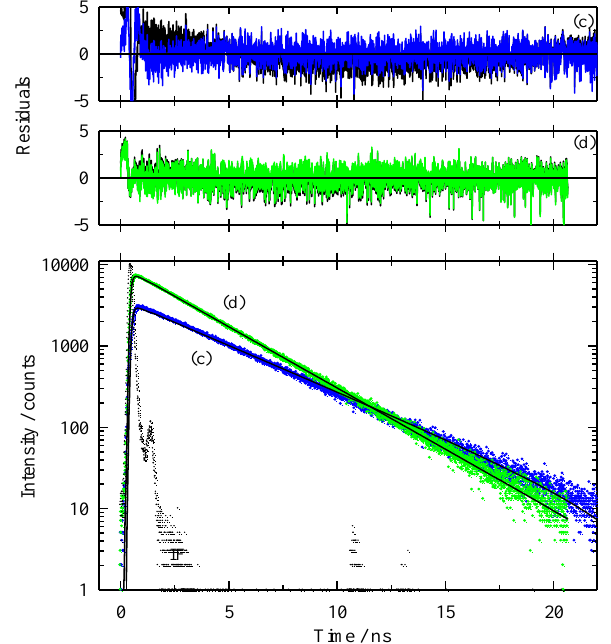
Figure 7. C153 intensity decays and subsequent fits in [P 6,6,6,14 ] + [Tf 2 N] − / scCO 2 at 323 K with excitation at 24,691 cm − 1 and emission at 22,222 cm − 1 . In the lower panel, dots are the measured decays and solid lines are the multi-exponential fits. The label “IF” shows the instrument response function. Blue trace “c” was measured at ρ r = 0.754 and green trace “d” was at ρ r = 1.726. The upper panels are the residuals to the sum-of-exponentials model with two time constants. Black lines are fits to a single exponential decay and colored lines are fits to a double exponential model. The complete set of fitting results are in Figure 8, and show the pre-exponential factors and 469 excited-state lifetimes across the range of scCO 2 density for C153 in neat scCO 2 (open circles) and 470 [P 6,6,6,14 ] + [Tf 2 N] − /scCO 2 (inverted triangles). The C153/scCO 2 results represent the monomer lifetime 471 benchmark. Interestingly, for gas phase C153 a lifetime of ~7 ns is the expected value in the absence 472 of any solute-solvent coupling [96], consistent with what might be expected in a low-density 473 supercritical fluid. However, since prior steady-state measurements clearly indicated density 474